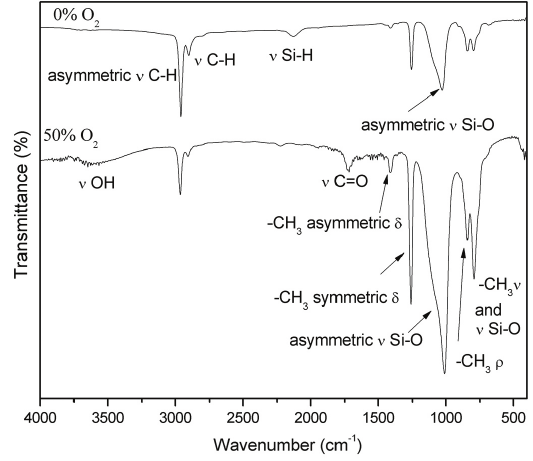
Figure 3. Infrared spectra of films deposited in plasmas with 0 and 50% of oxygen. The ν, δ and ρ symbols mean stretching, deformation and rotation, respectively.